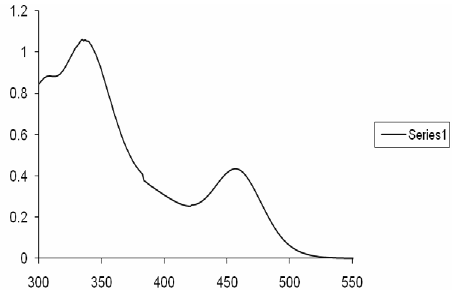
Figure 1 . Absorption spectrum of the complex anion [BiI